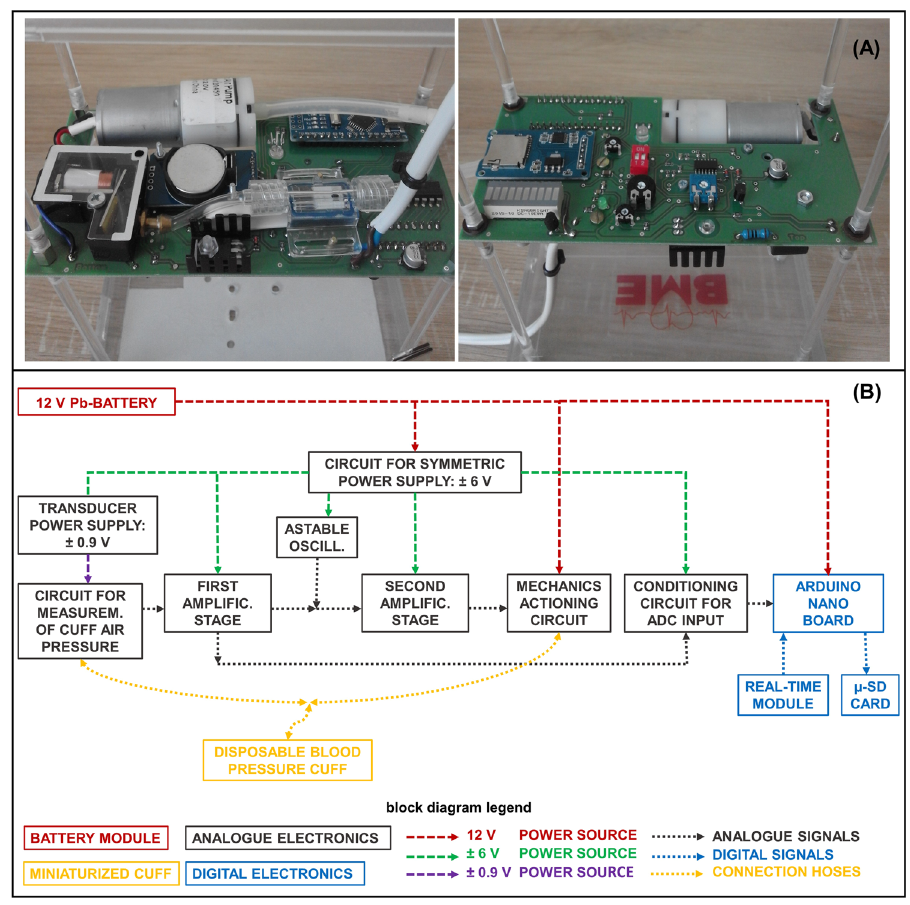
Figure 1. Electronic circuit ( A ) and block diagram of the complete system ( B